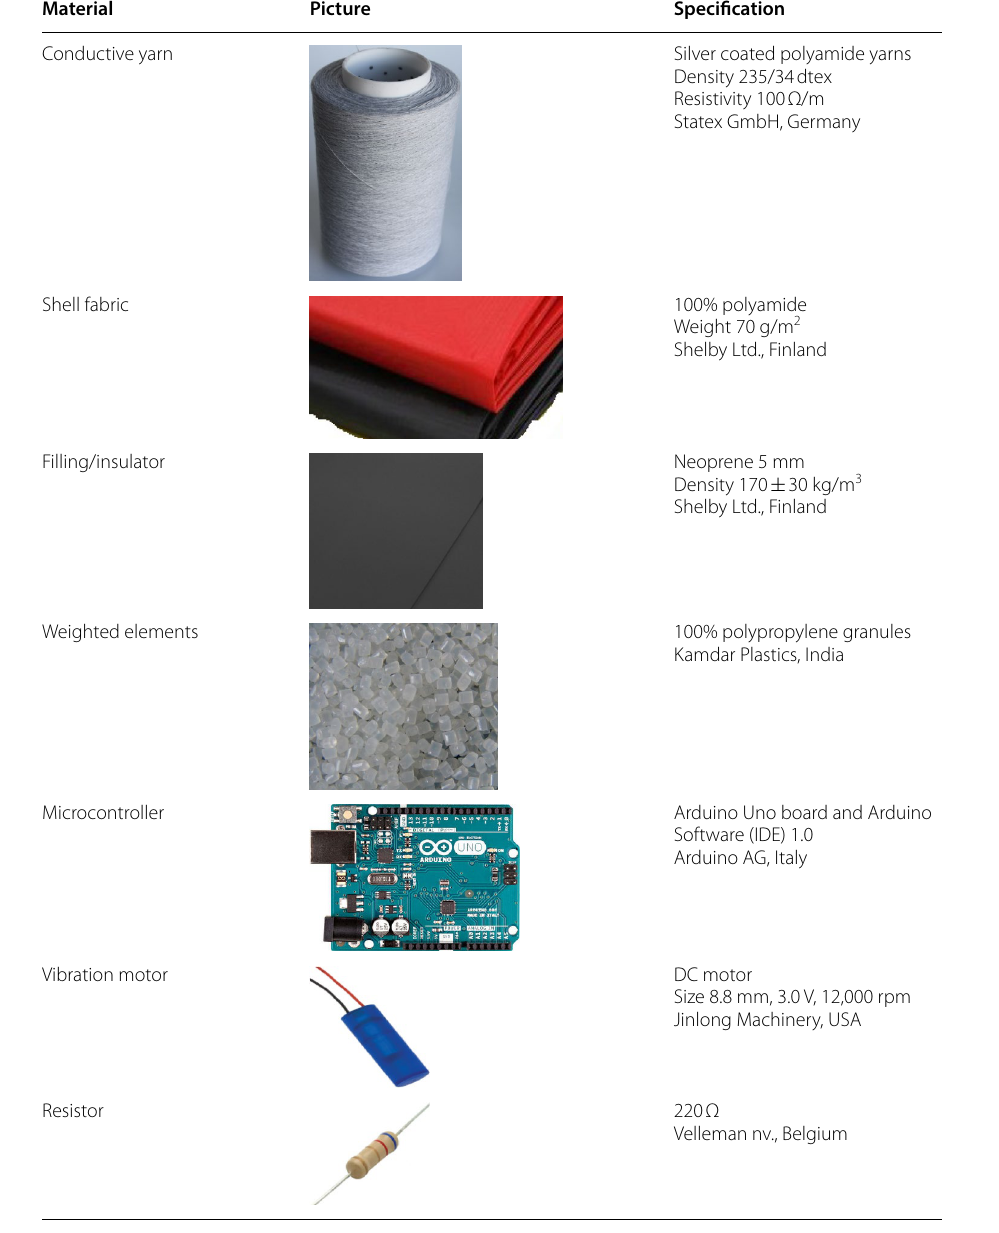
Table 1 List of materials and devices used Material